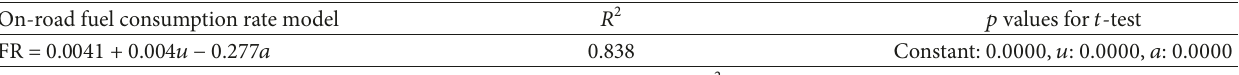
Table 5: On-road fuel consumption model of motorcycles.